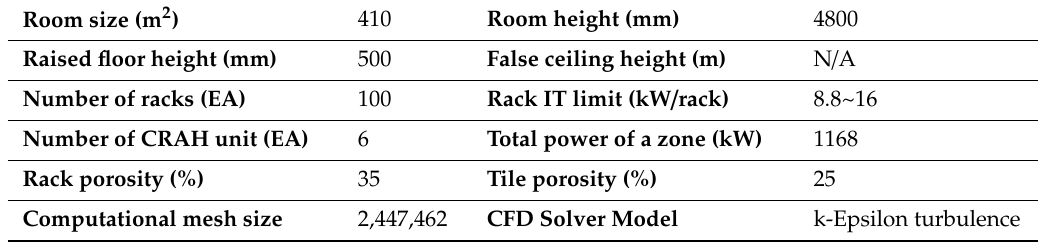
Figure 3. Basic analysis model; ( a ) server rack arrangement in IT server room, ( b ) server rack modeling and ( c ) CRAH unit modeling. 2.3.3. Hot Aisle Containment Figure 4 displays the analysis model of HAC, which is the air distribution method for the IT server room. The containment height was the same as the server rack in each row, and the RA ducts were installed at the top so that the returned air could reach the CRAH units. The ducts of the containment were installed at each hot aisle and they were connected again to the RA chamber. It